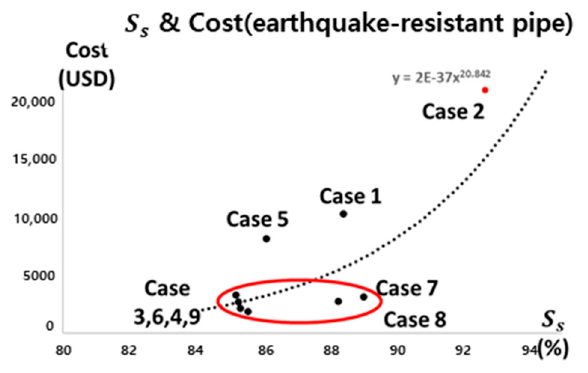
Figure 7. System Serviceability ( S s ) of Each Critical Path vs. Cost of Earthquake Resistance.